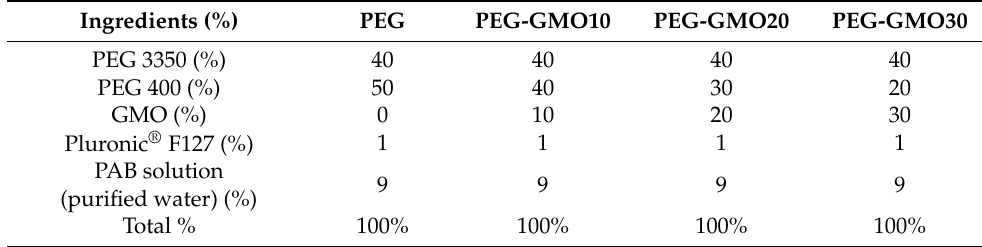
Table 1. Composition of PEG-LC